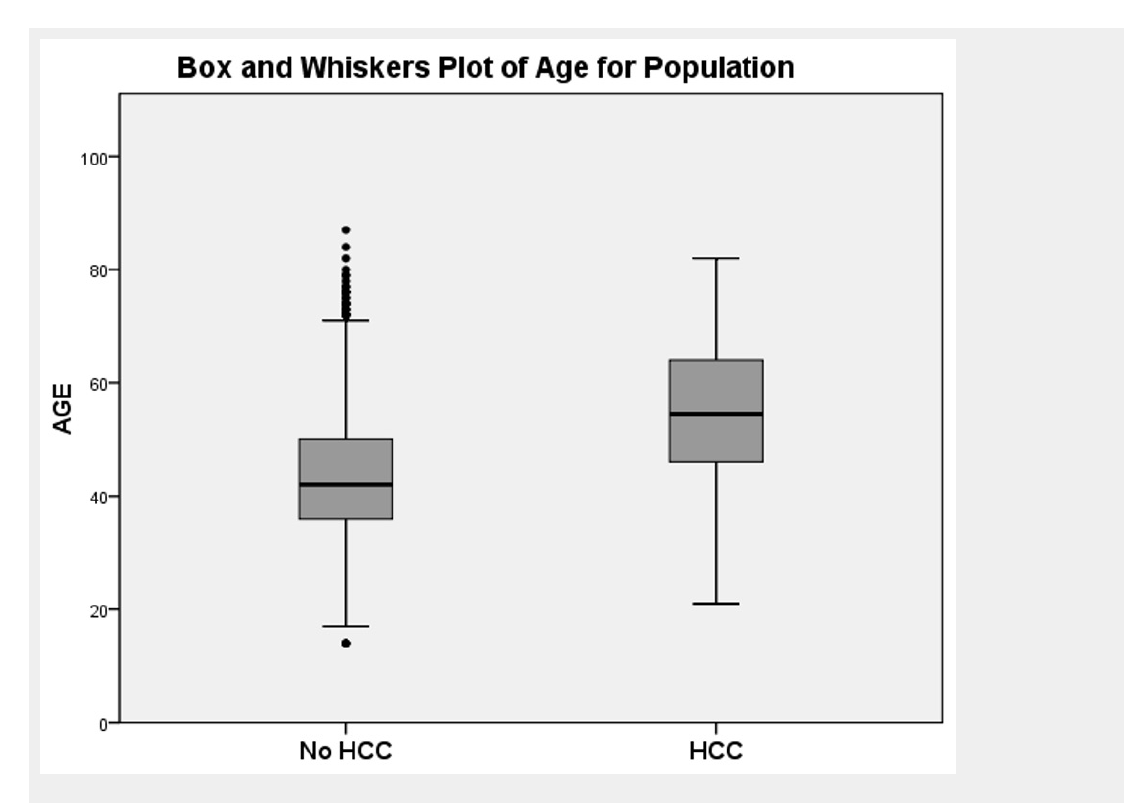
Figure 2 Box and whiskers plot of age for non-HCC and HCC